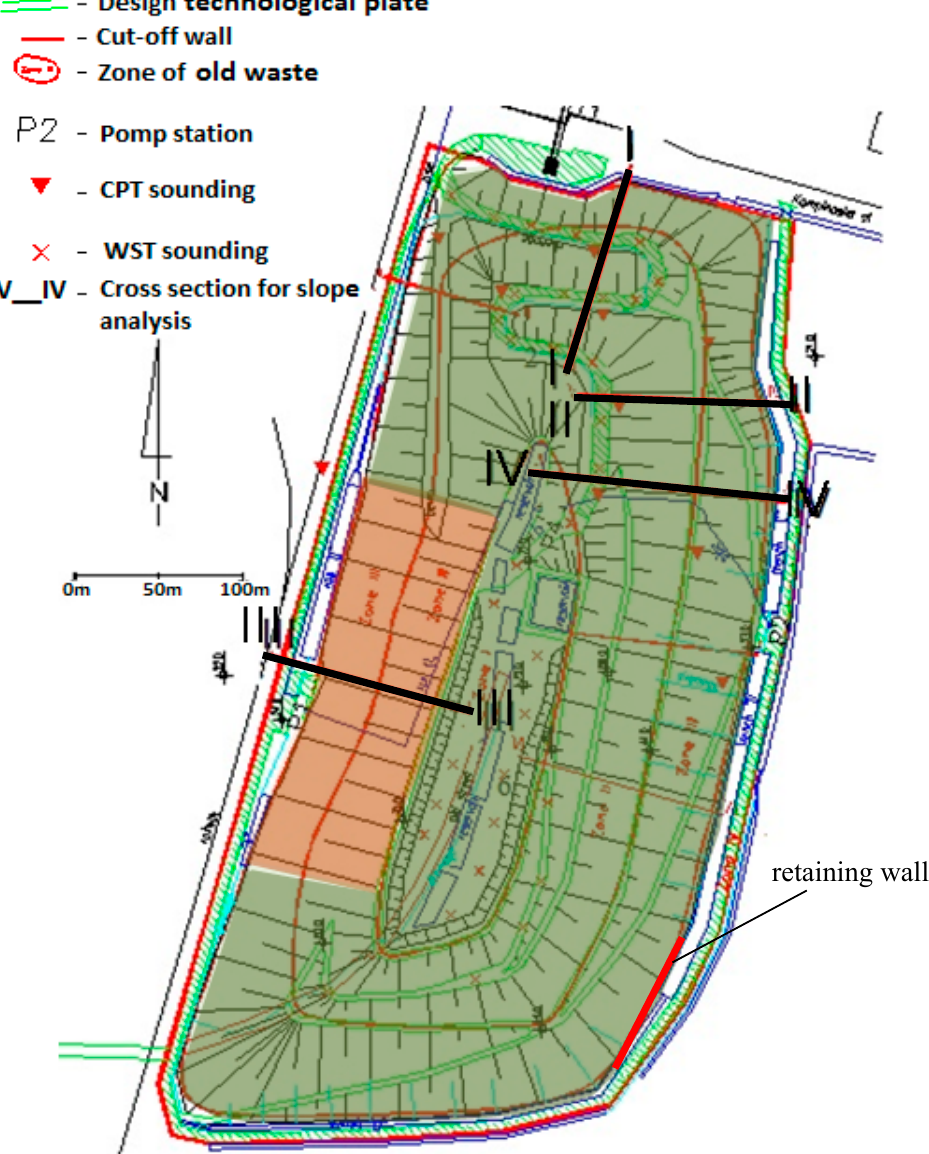
Figure 7. Geotechnical safety assessment based on “traffic lights” approach applying observational method framework—with landfill slopes reinforcement.